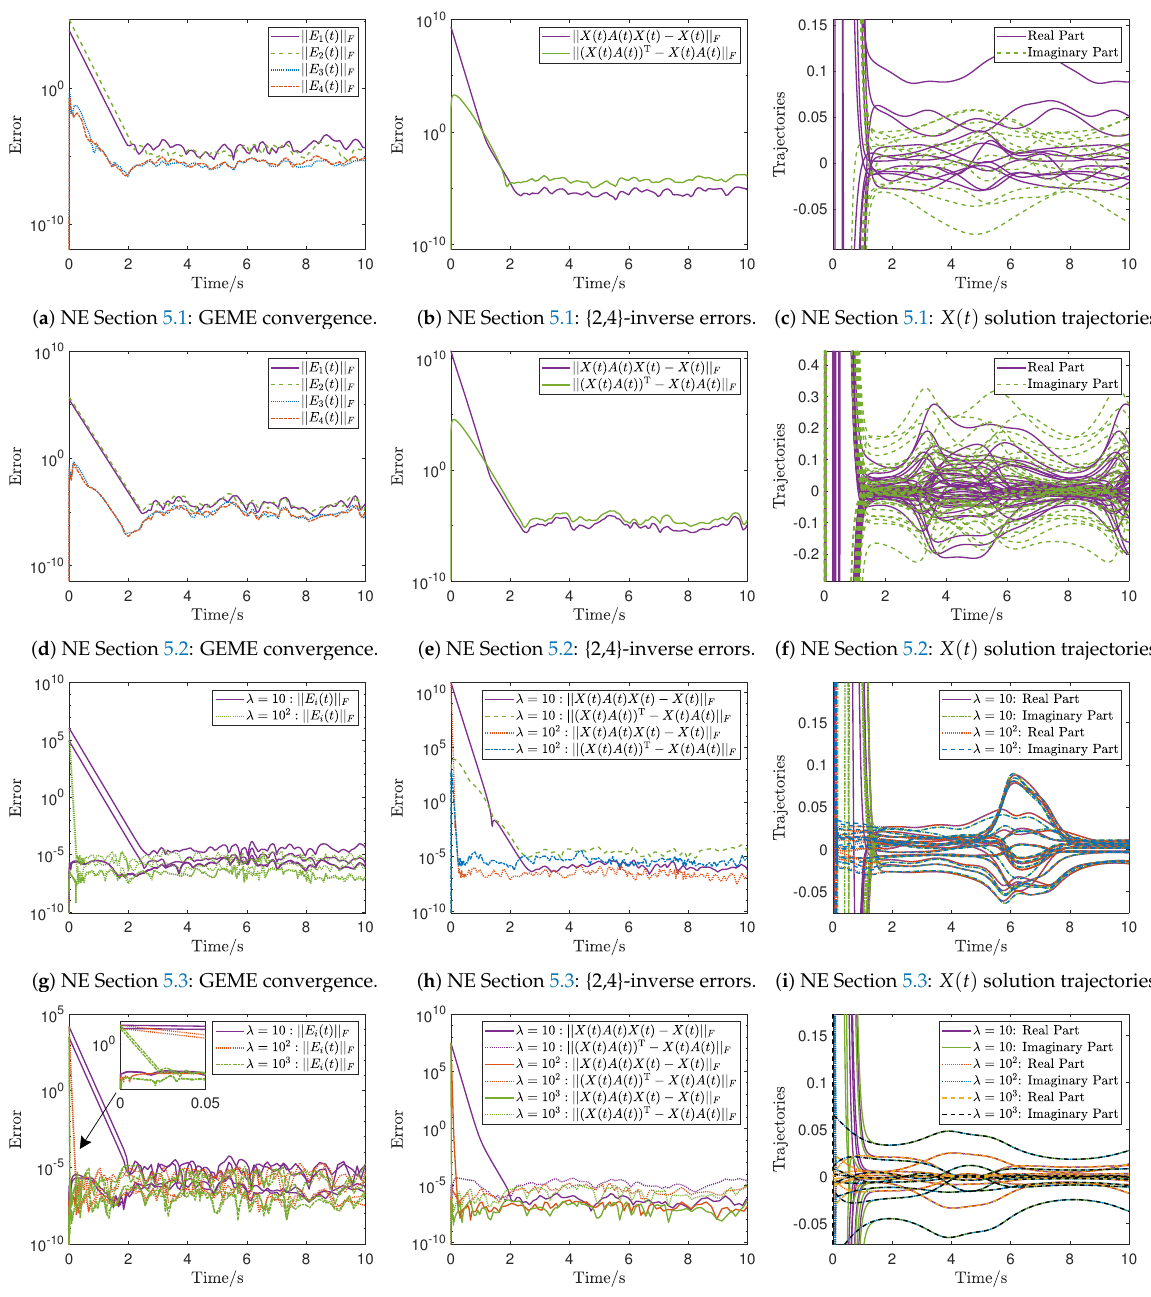
Figure 1. GEME convergence, {2,4}-inverse errors, and trajectories of the ZNN24I model’s X ( t ) solutions for the NEs in Sections